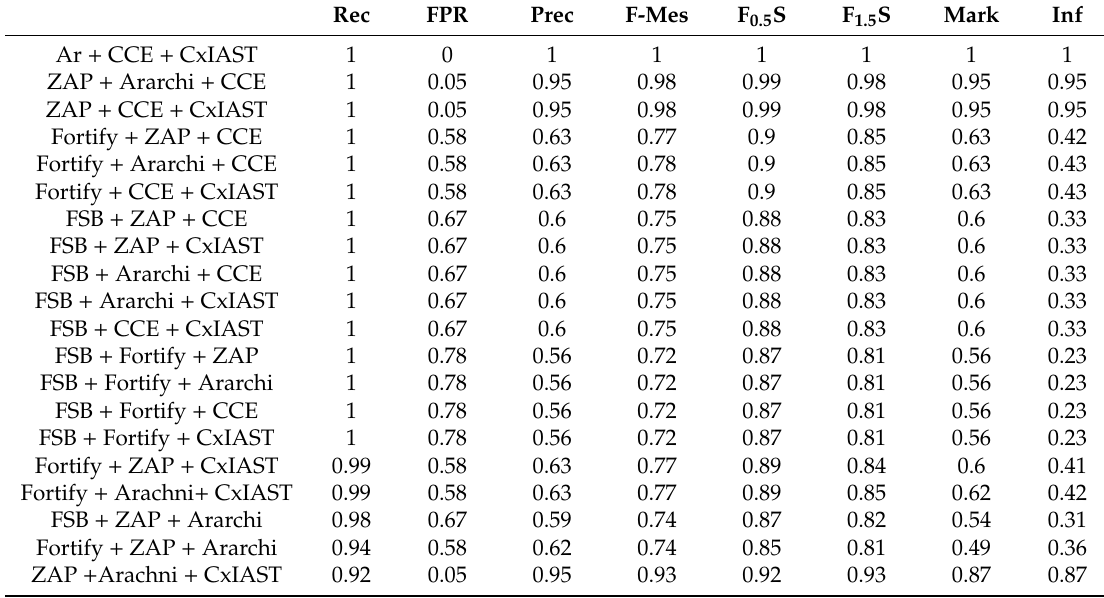
Table 7. Application of the metrics to 3-tools